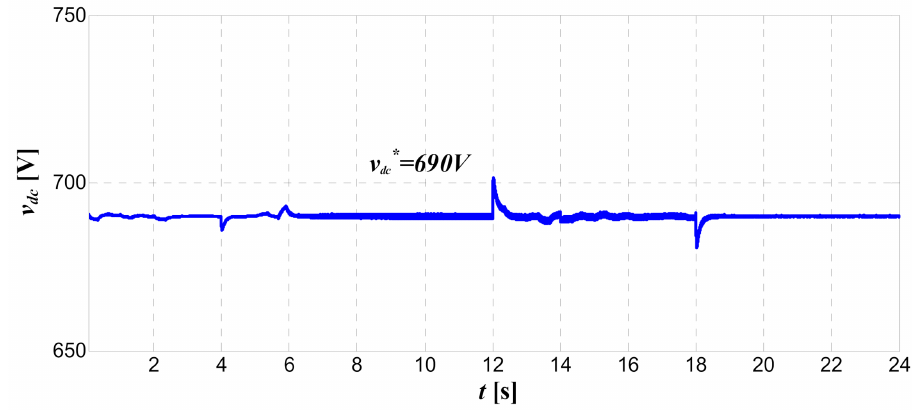
Figure 23. The course of DC link voltage v dc of